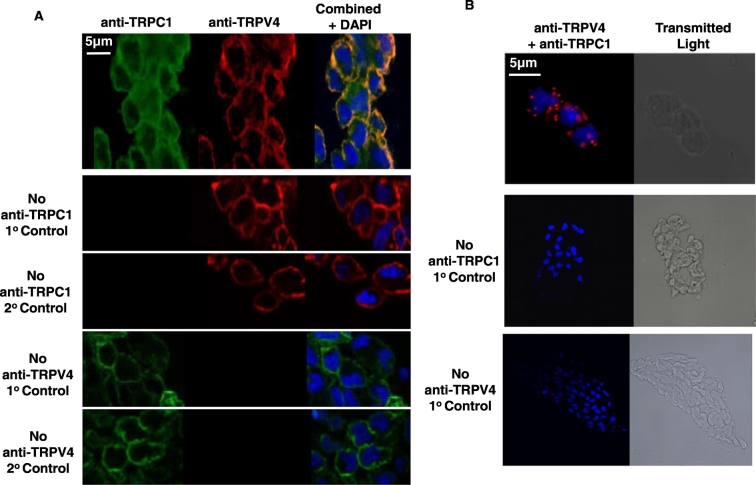
Expression and co-localisation of heteromeric TRPV4-TRPC1 channels in freshly isolated mesenteric artery ECs.A, Representative immunocytochemical images of TRPV4 (red) and TRPC1 (green) proteins in rabbit mesenteric artery ECs, showing expression and co-localisation (yellow) at the plasma membrane. Representative images showing that the absence of primary anti-TRPV4 and anti-TRPC1 antibodies, or their corresponding secondary antibodies failed to produce any immunocytochemical staining. B, Representative images from proximity ligation assays illustrating TRPV4 and TRPC1 co-localisation staining (red) in rabbit ECs. In the absence of primary anti-TRPV4 and anti-TRPC1 antibodies failed to produce any PLA staining.